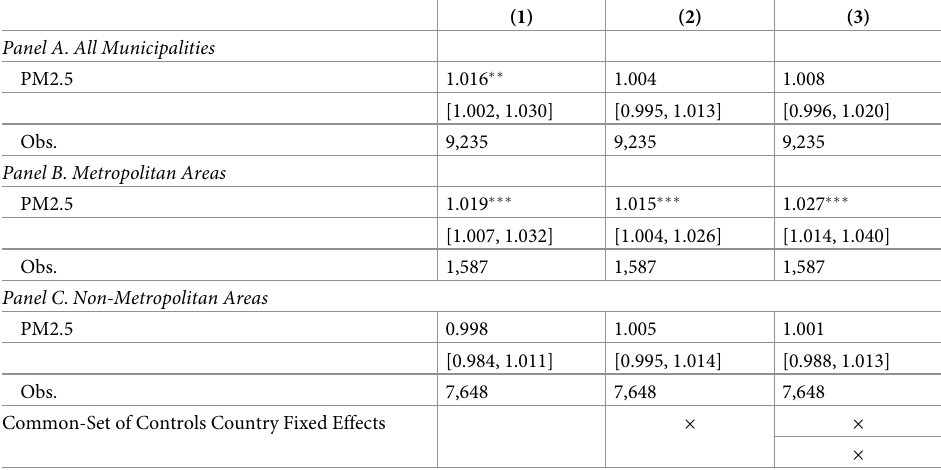
Table 3. Long-term average PM 2.5 exposure and COVID-19 mortality rate in Latin American